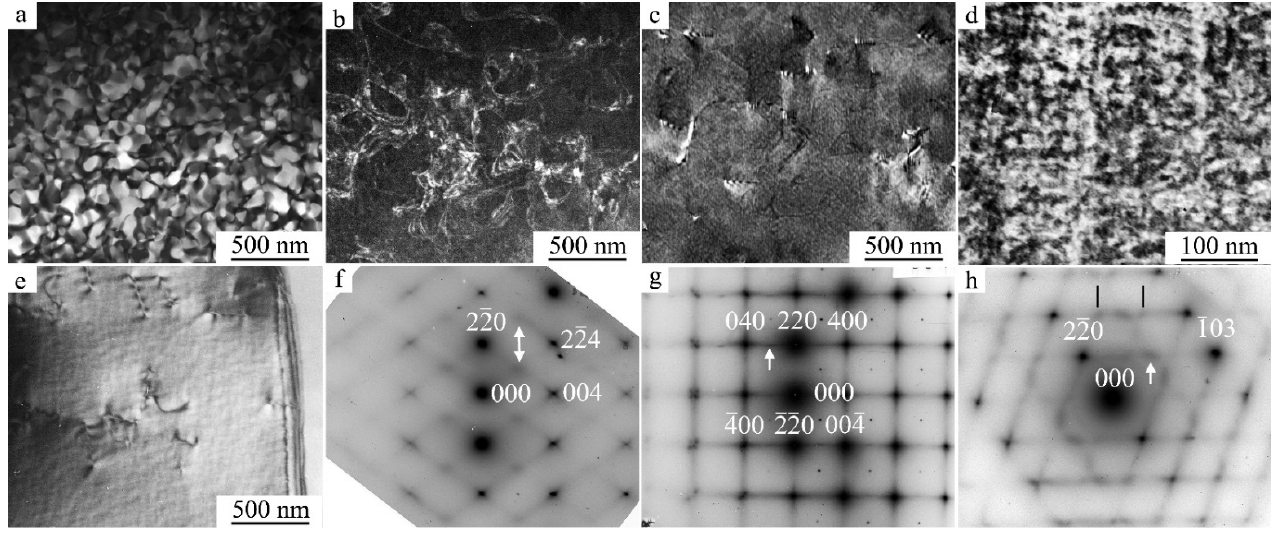
Figure 11. ( a – c ) Dark- and ( d , e ) bright field TEM images of ( a , b ) APB and ( c – e ) tweed contrast and ( f – h ) corresponding SAED patterns, with zone axis ( f ) [110], ( g ) [001], and ( h ) [331] of D0 3 Cu-14Al-3Ni alloy. Observations at ( e , f ) 450 K, and ( a – d , g , h )–RT